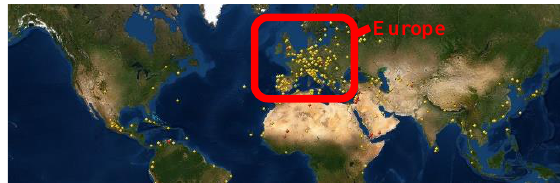
Figure 1. Historic urban landscapes world-wide and their concentration in Europe (UNESCO